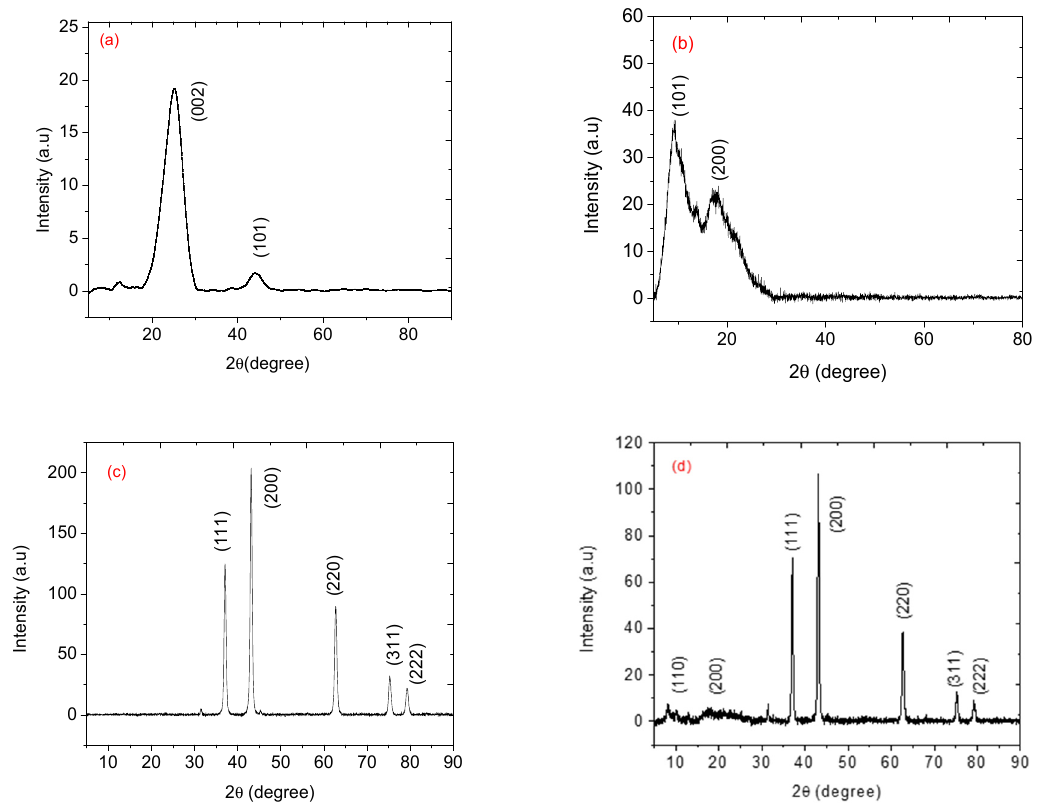
Figure 7. XRD patterns of ( a ) CNPs, ( b ) CA, ( c ) NiO NPs and ( d ) 1:1:3 mass ratio NiO NPs-CNPs-CA composite.